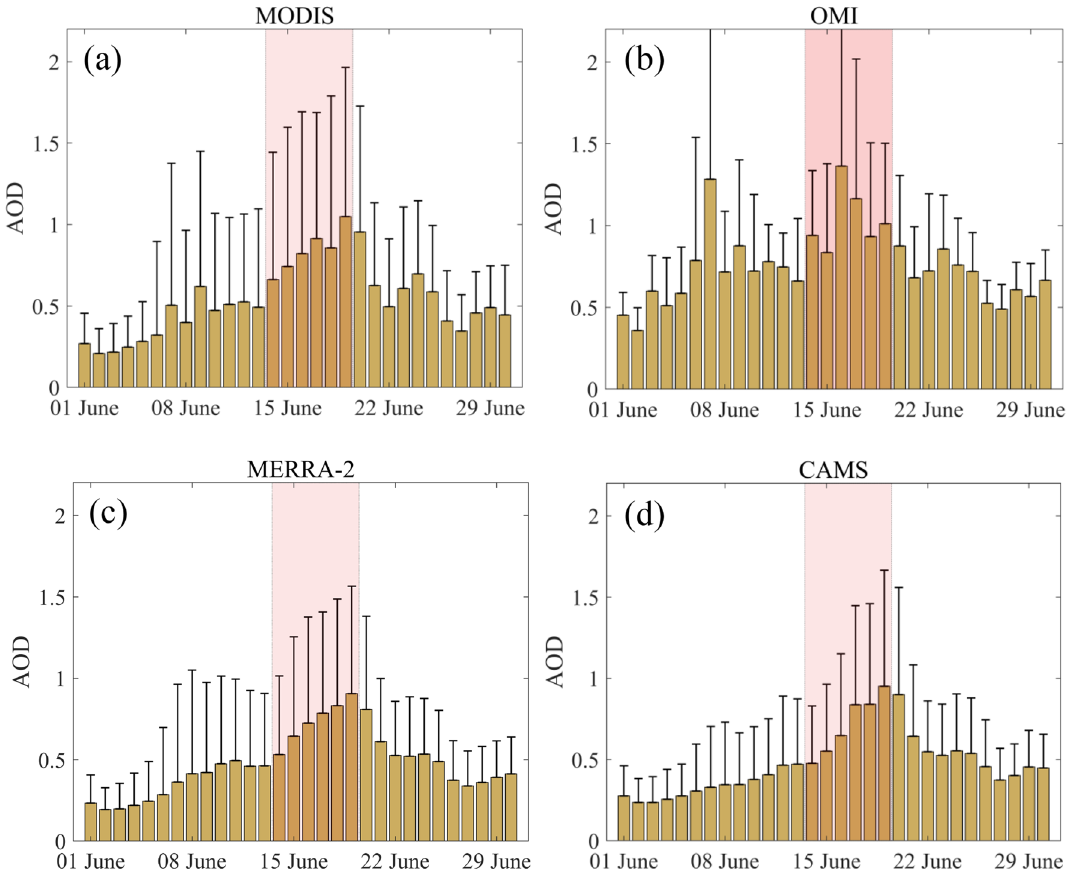
Figure 2. Area averaged time series of aerosol optical depth (AOD) during June 2020 from ( a ) MODIS, ( b ) OMI, ( c ) MERRA-2 and ( d ) CAMS. The shade is indicating the period of the dust storm (14–19, June 2020). The error bars indicate + 1σ of the daily datasets over the selected area of